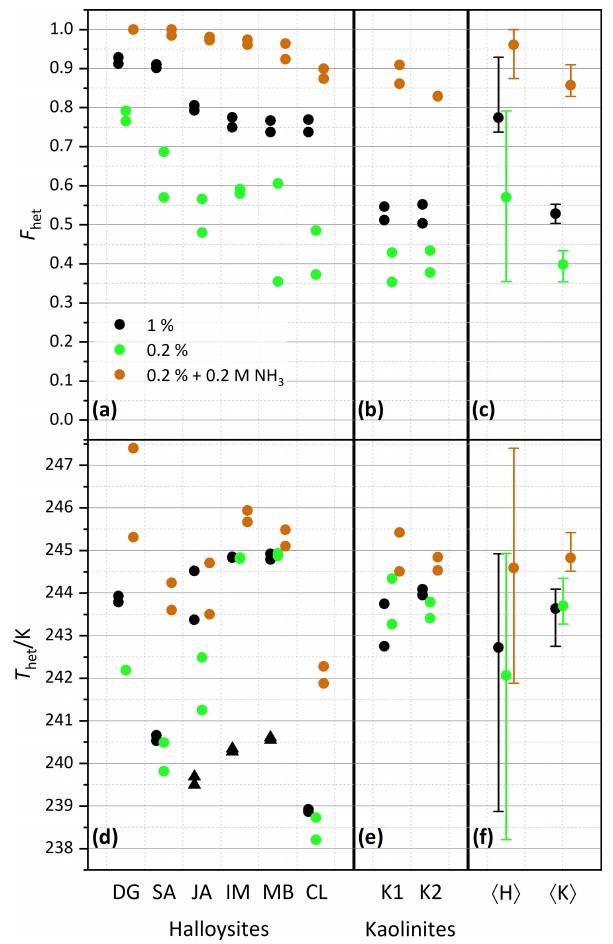
Figure 3. Summary of heterogeneously frozen factions F het (a– c) and heterogeneous freezing onset temperatures T het (d–f) for dust samples, as obtained from the source regions without further milling. Dust sample codes, as listed at the bottom of the figure, are identical to those in Fig. 2. Experiments have been performed for 1wt% (black symbols), 0.2wt% (green), and 0.2wt% plus 0.2M ammonia/ammonium (brown). Triangles represent the onset of a second freezing peak when present and evaluable. Each symbol corresponds to an individual suspension preparation and DSC mea- surement. (a, d) Halloysites. (b, e) Kaolinites. (c, f) Averages for all halloysites, (cid:104) H (cid:105) , and kaolinites, (cid:104) K (cid:105) , with vertical bars representing the spread (min–max) of all